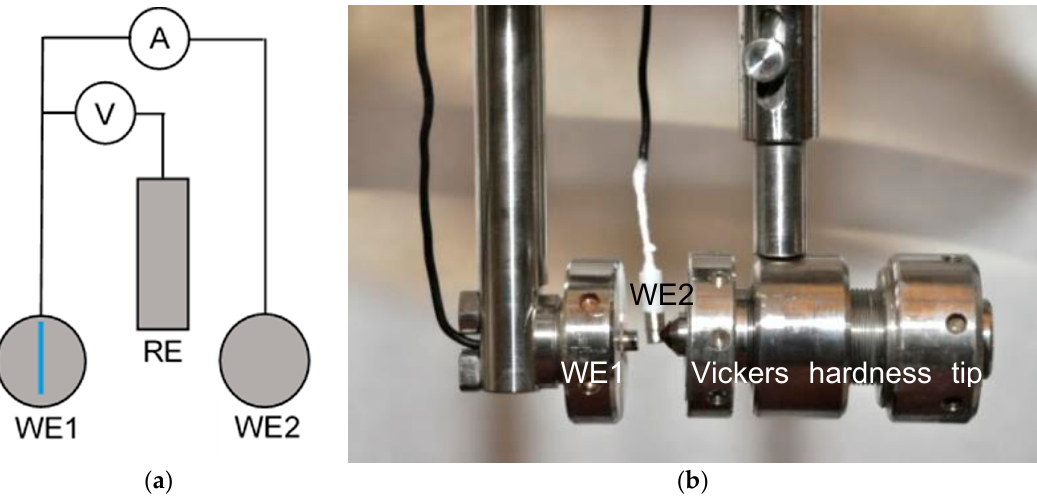
Figure 1. Schematic ( a ) and experimental setup ( b ) of scratch test; WE1—working electrode 1 (scratch is blue vertical line in ( a )); WE2—working electrode 2 (not scratched); RE—reference electrode.